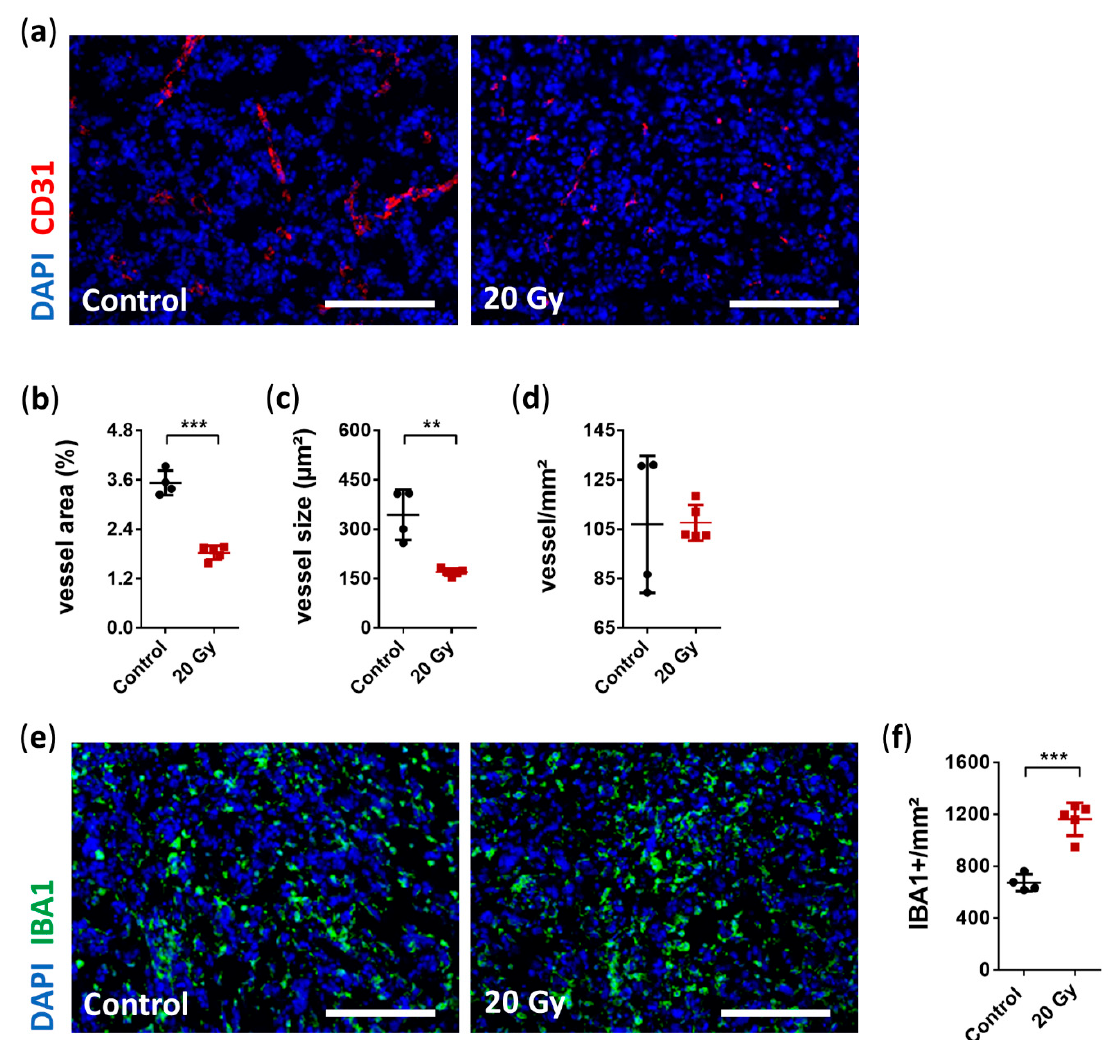
Figure 5. Immunohistological analysis of early radiobiological effects on tumor vasculature and the accumulation of tumor-associated microglia and macrophages (TAMs). ( a ) Representative immunostaining images of reduced tumor vasculature after irradiation (CD31: red, DAPI: blue; scale bar = 200 µ m). ( b ) Quantitative analysis revealed a significantly decreased total vessel area in the irradiated group compared with the non-irradiated group (data are presented as the mean ± SD of each group. Individual values of each animal are provided as a single dot; n = 4–5 per group; *** p < 0.001). ( c ) Average vessel size was also significantly reduced after irradiation (data are presented as the mean ± SD of each group. Individual values of each animal are provided as a single dot; n = 4–5 per group; ** p < 0.01). ( d ) In contrast, there was no difference in vessel counts per mm 2 between the irradiated and non-irradiated group (data are presented as the mean ± SD of each group. Individual values of each animal are provided as a single dot; n = 4–5 per group). ( e ) Representative immunostaining images showing increased TAM accumulation six days after irradiation (Iba1: green, DAPI: blue; scale bar = 200 µ m). ( f ) Quantification of positively stained Iba1 cells per mm 2 showed enhanced accumulation of 73% in irradiated vs. non-irradiated group (data are presented as the mean ± SD of each group. Individual values of each animal are provided as a single dot; n = 4–5 per group; *** p <